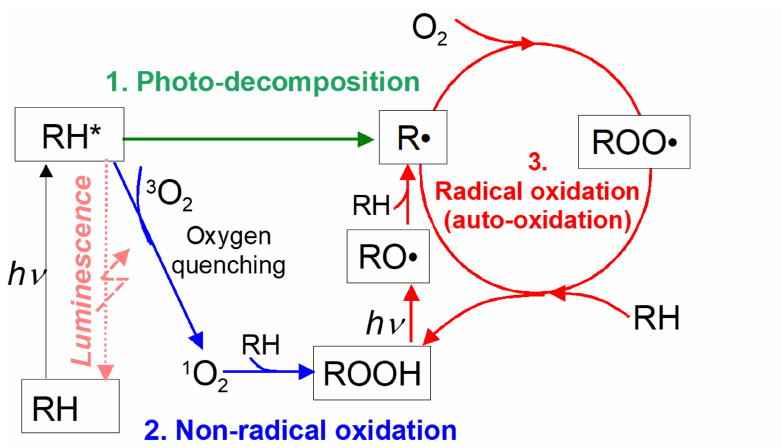
Figure 1. Schematic of photodegradation of an organic luminophore